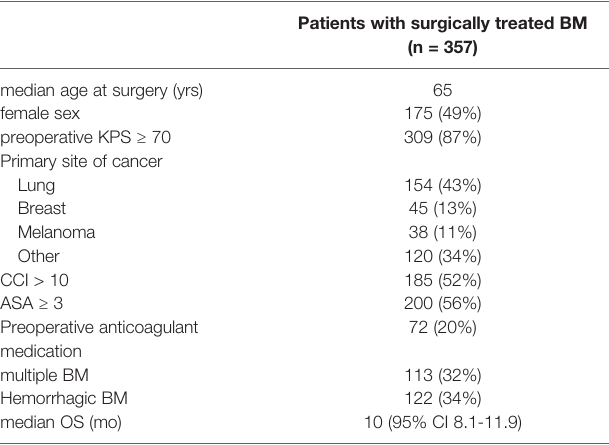
TABLE 1 | Patient characteristics.